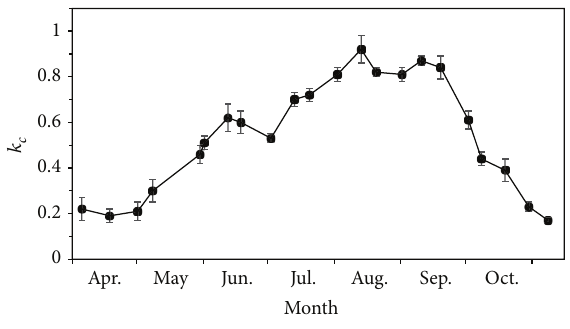
Figure 3: Seasonal variation in the 𝑘 𝑐